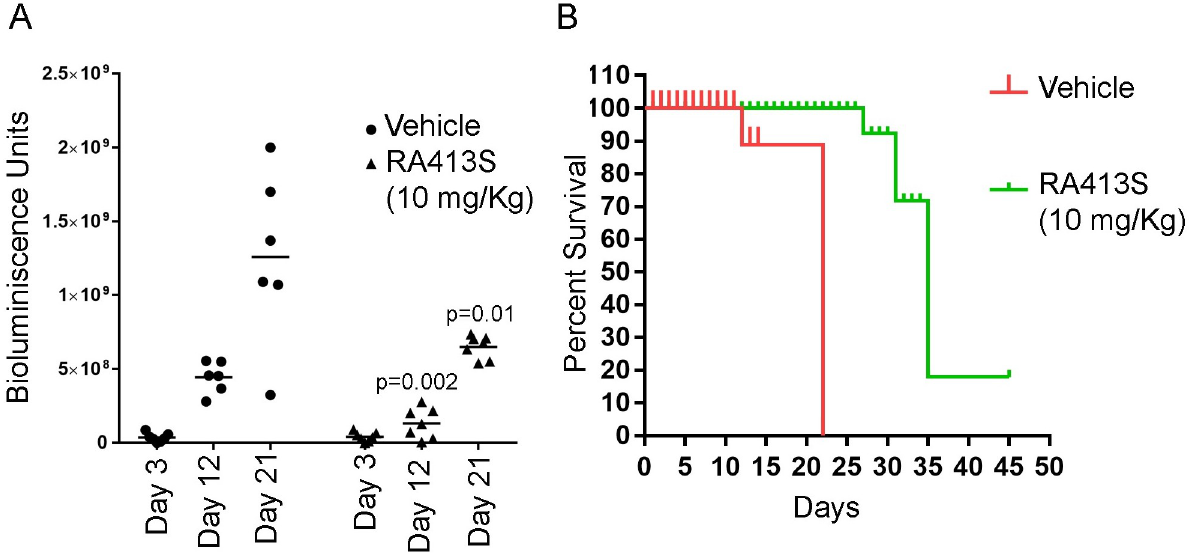
Fig 9. Tumor growth inhibition effect of RA413S against ovarian cancer xenograft. (A) Female nude mice bearing ES2 tumor expressing firefly luciferase (n = 14) were imaged before and after unblinded treatments either with vehicle (25% β -hydroxypropyl cyclodextrin in water, n = 7) or RA413S (n = 7, 10mg/Kg/every 3 days/12 doses total) and imaged using IVIS200 for the bioluminescence expressed by the tumors. One mouse in the vehicle group died on day 12 and was not included for the day 12 and 21 time points. (B) Kaplan-Meier survival curve and log rank analysis demonstrates nude mice treated with RA413S have extended survival time compared to the vehicle treated mice (p < 0.001).